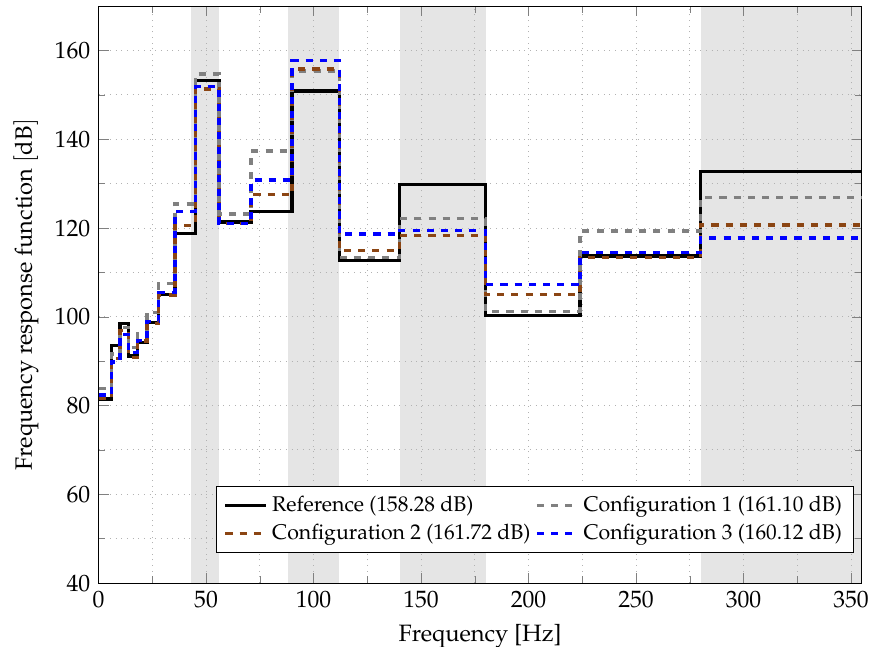
Figure A13. One-third octave band representation of FRF of WTS test specimen for three different configurations. SL value of surface velocity is given in dB.